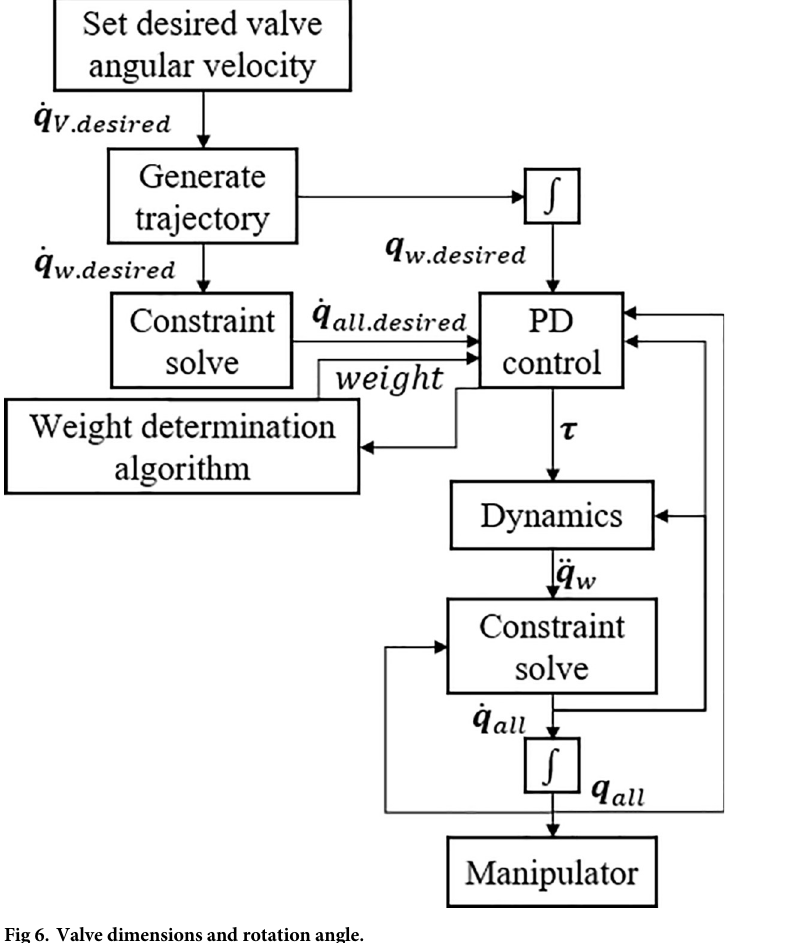
Fig 6. Valve dimensions and rotation